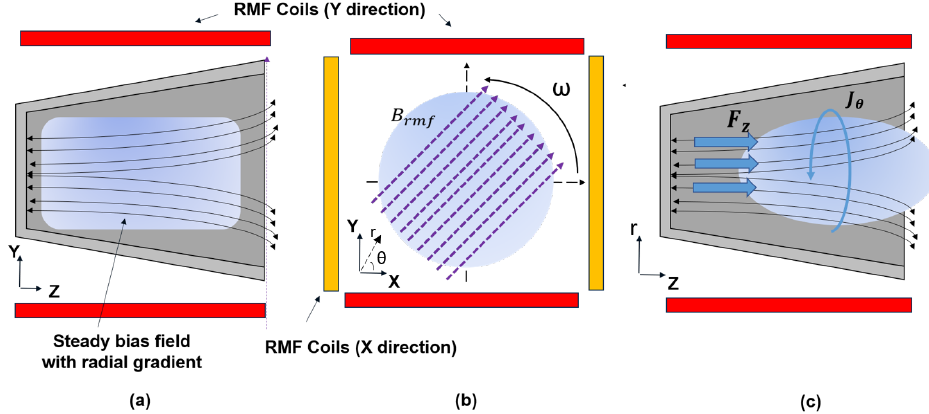
Figure 10. RMF-FRC Operation—( a ) Side view cross-section in the r - z plane of the thruster illustrating how ionized gas is injected into the discharge chamber. A steady bias magnetic field with radial gradient is present. ( b ) End-on view of the thruster in the r - θ plane depicting two sets of coils oriented in the x - and y -directions that generate a rotating magnetic field (RMF) by using sinusoidal currents at frequency ω applied 90 ◦ out of phase. The RMF induces axial and azimuthal currents. ( c ) Side view of the r - z plane illustrating FRC formation. Large azimuthal currents form the plasmoid and interact with the external radial magnetic field component to axially accelerate the plasmoid via a Lorentz body